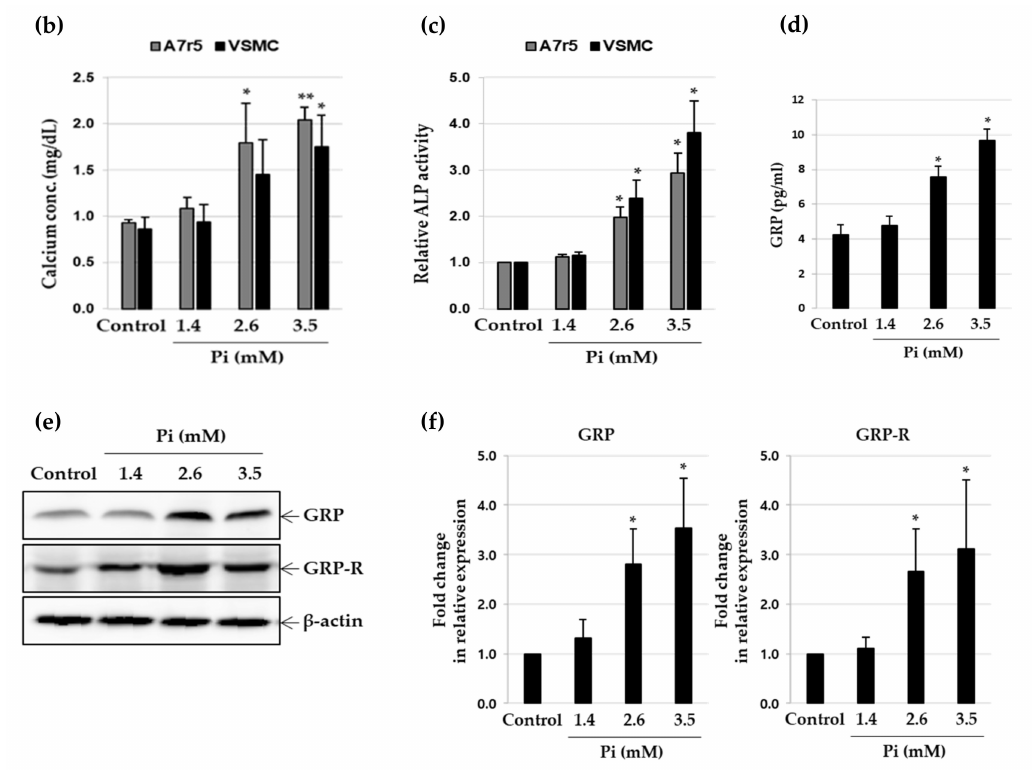
Figure 1. Expression of gastrin-releasing peptide (GRP) and GRP receptor during Pi-induced calcification in vascular smooth muscle cells (VSMCs). A7r5 and primary VSMCs were cultured in calcification medium (1.4, 2.6 and 3.5 mM Pi) for 7 days. ( a ) Calcium deposition was analyzed by stainingwithARS(left), followedbymeasurementofabsorbancetoevaluatethedegreeofmineralization (right). * p < 0.05; ** p < 0.01 vs. control. ( b ) Calcium content was measured by colorimetric calcium assay. * p < 0.05; ** p < 0.01 vs. control. ( c ) ALP activity was measured and normalized to protein content, for quantitative analysis. * p < 0.01 vs. control. ( d ) Secreted GRP content in the conditioned cell culture medium was measured using ELISA. * p < 0.01 vs. control. ( e ) GRP and GRP